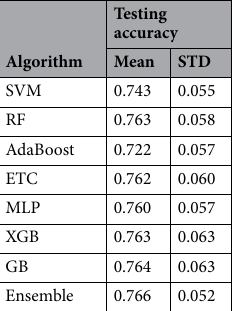
Table 1. The accuracy of training and testing for single and ensemble models.